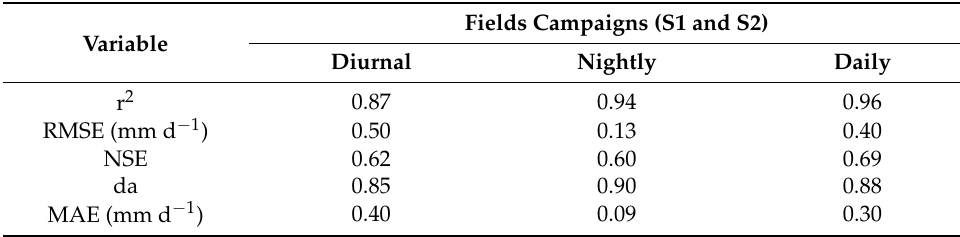
Table 3. Statistical parameters for diurnal, nightly, and daily E.